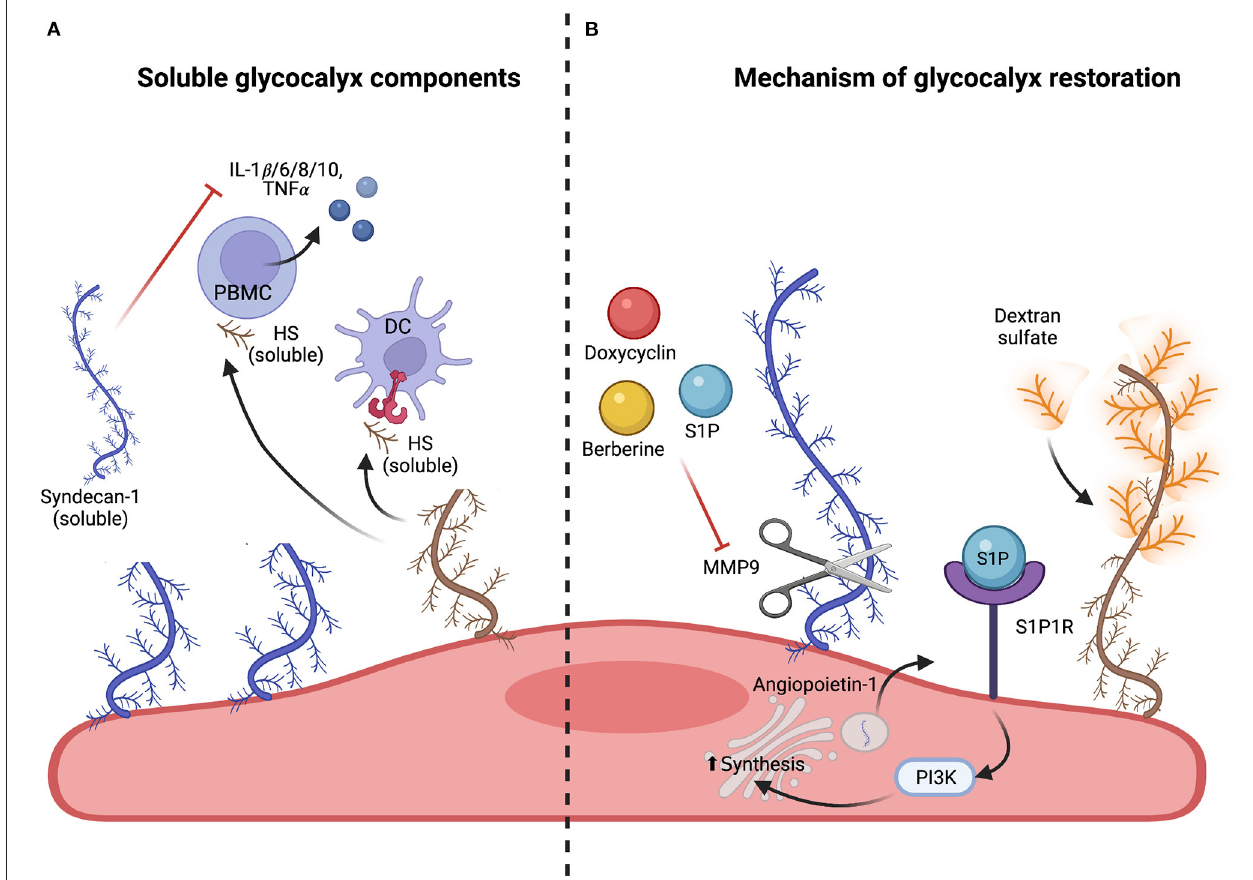
FIGURE 4 | Soluble glycocalyx components and mechanism of glycocalyx restoration. (A) Effect of soluble glycocalyx components. Released soluble glycocalyx components such as HS (brown), syndecan-1 and − 3 (blue) can propagate inflammatory responses by activating peripheral blood mononuclear cells (PBMCs) and dendritic cells (DCs) via TLR4 signaling. This leads to release of pro-inflammatory cytokines and DC maturation. However, soluble syndecan-1 (blue) has also been shown to reduce inflammation by directly inhibiting cytokine and chemokine release and blocking leukocyte adhesion. (B) Protection and restoration of the endothelial glycocalyx. Maintenance of glycocalyx integrity can be achieved by inhibition of sheddases. Doxycycline (shown in red), berberine (shown in yellow) or S1P (shown in blue) have been shown to directly inhibit matrix metalloproteinase 9 (MMP9) and therefore impede glycocalyx shedding. Regeneration of the glycocalyx can be achieved by upregulating the expression and extravasation of glycocalyx components such as syndecans with S1P and angiopoietin-1 or by replacing shed components such as HS with structurally similar agents such as dextran sulfate (shown in orange), a highly branched